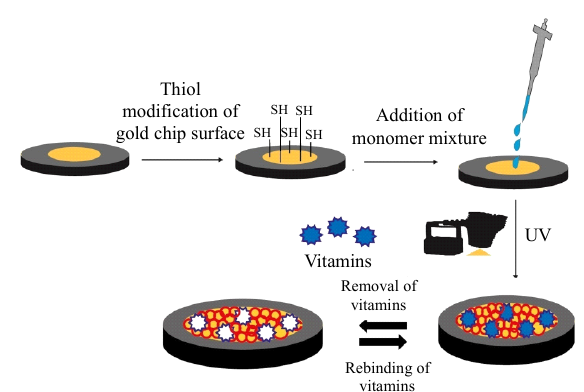
Fig. 1 Schematic representation of the preparation of vitamin imprinted chip surface.